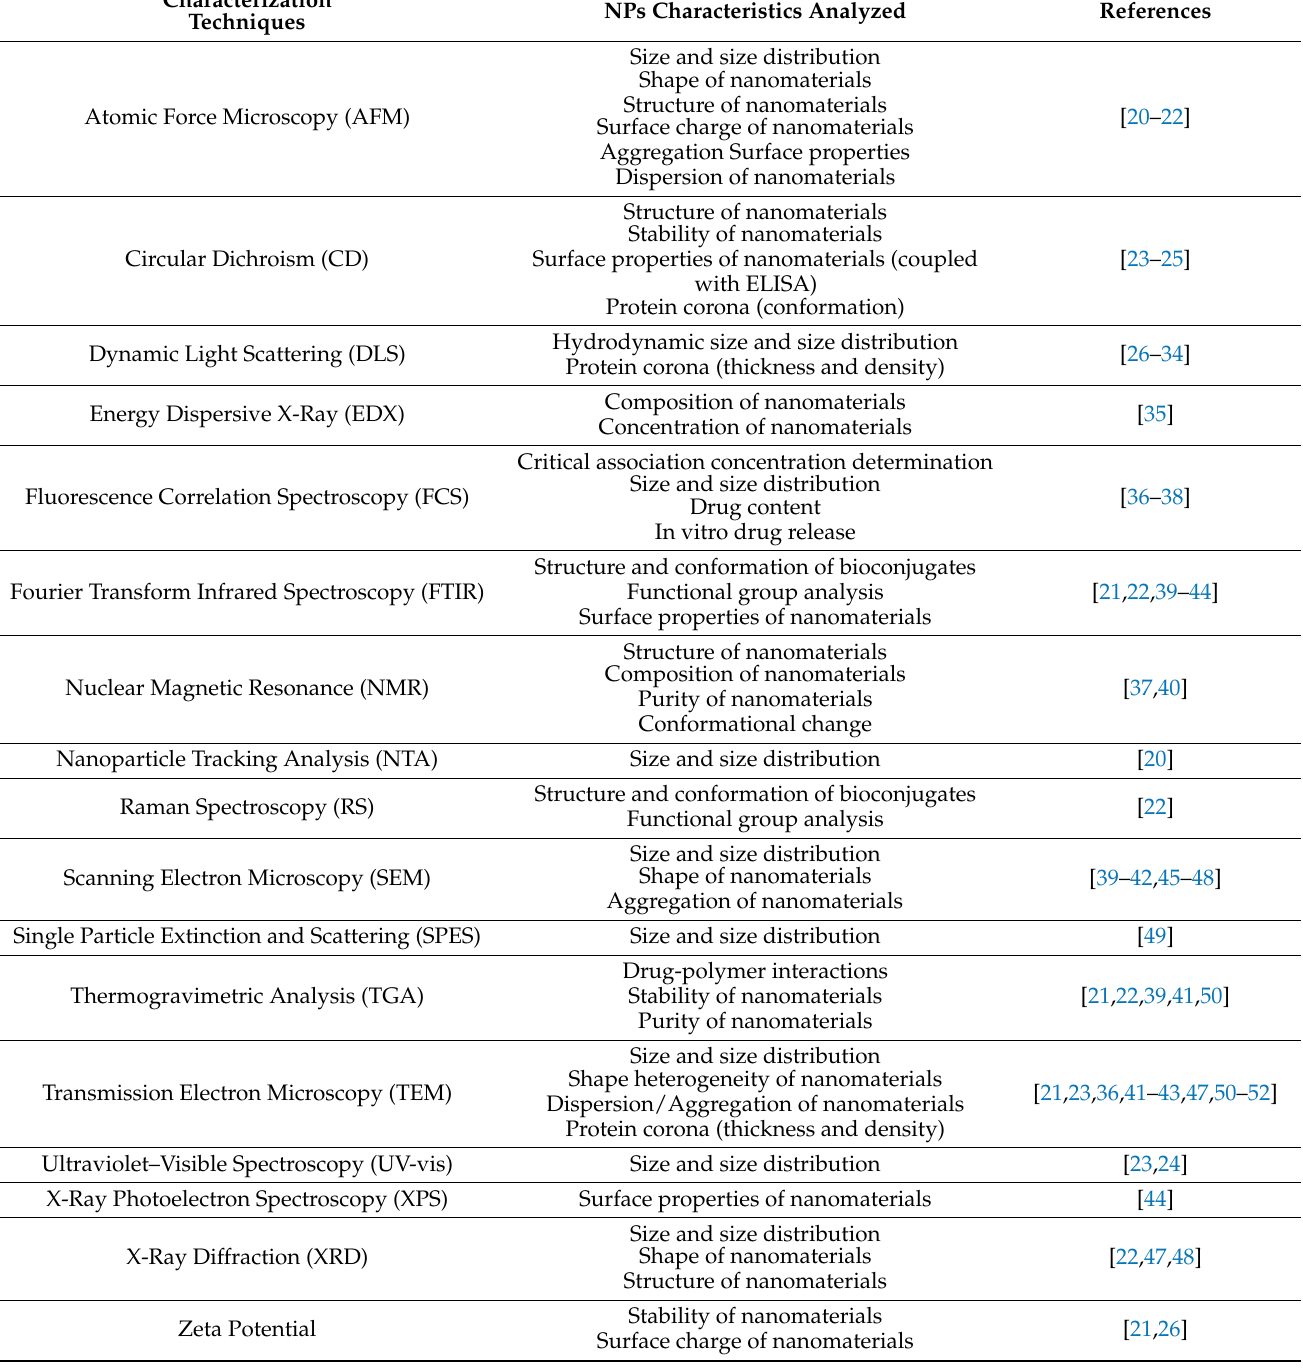
Table 1. Principal techniques for the evaluation of the physicochemical features of polymeric